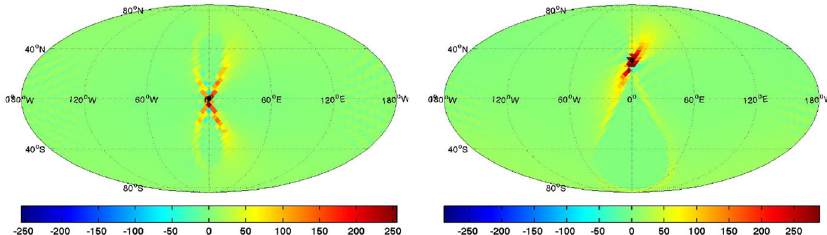
Fig. 49 Point spread functions for gravitational-wave power for the LIGO Hanford–LIGO Livingston detector pair. Left panel point source at the center of the map, (θ,φ) = ( 90 ◦ , 0 ◦ ) . Right panel point source at (θ,φ) = ( 60 ◦ , 0 ◦